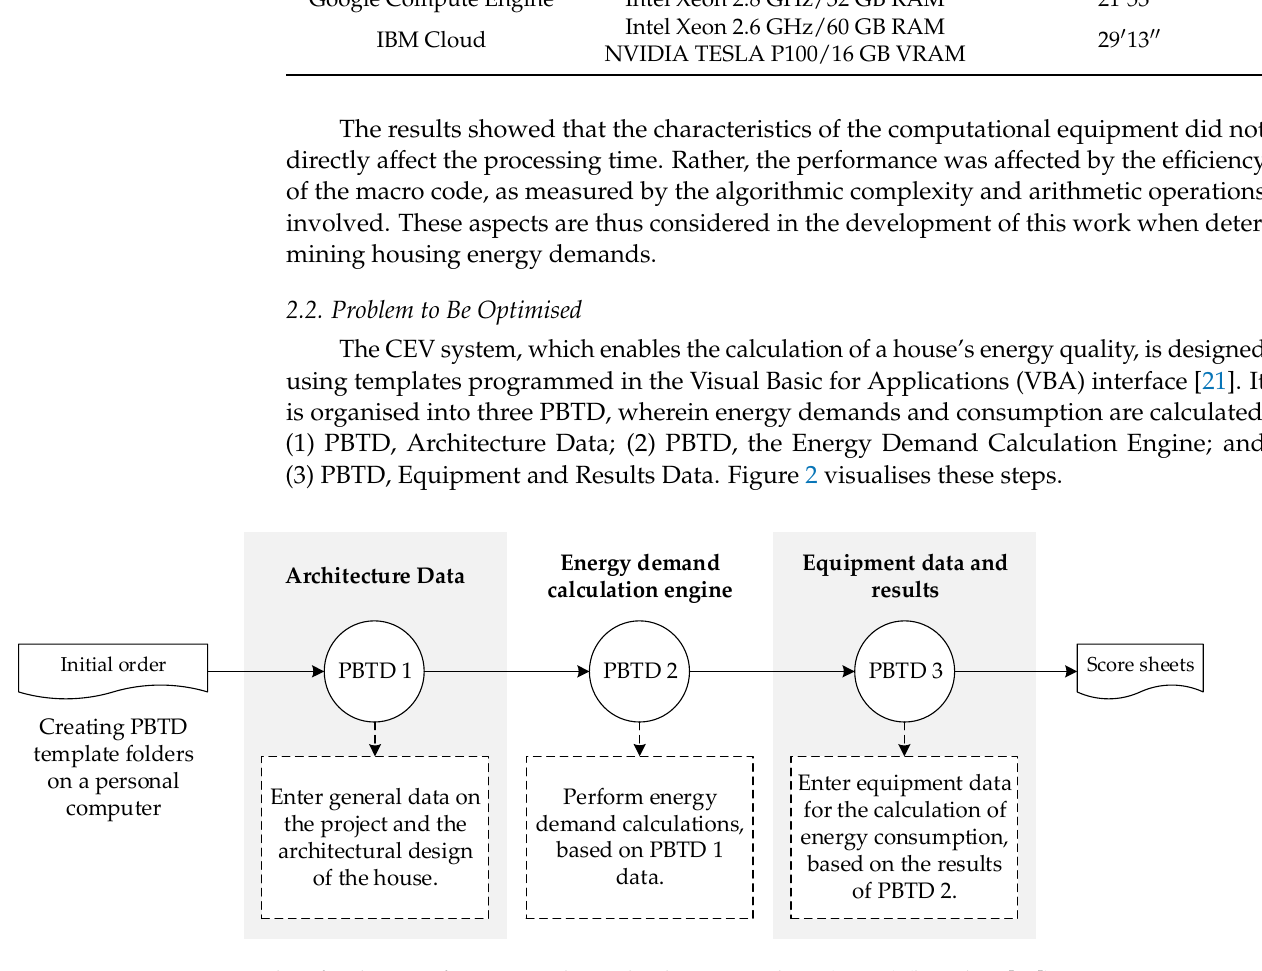
Table 2. Comparative results of the preliminary testing process.